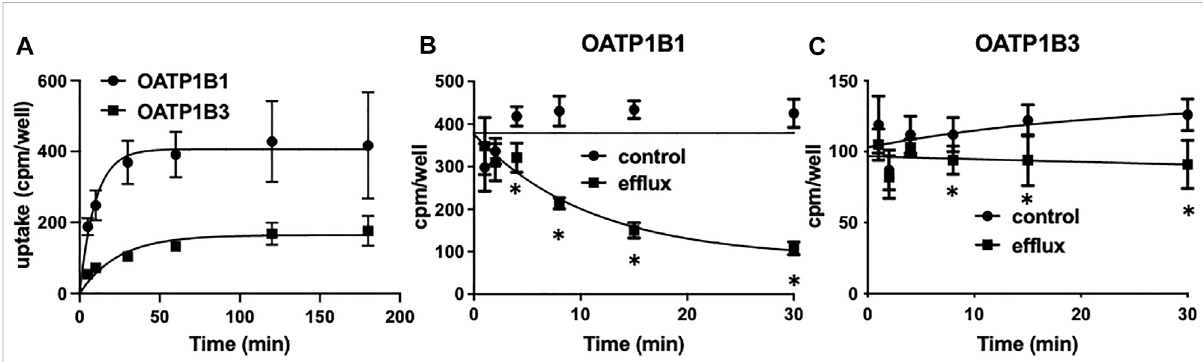
FIGURE 1 OATP1B1- and OATP1B3-mediated time-dependent uptake (A) and ef fl ux (B,C) of estradiol-17 β -glucuronide using stable CHO cell lines. (A) Uptake of 10 nM [ 3 H]-estradiol-17 β -glucuronide into CHO cells stably expressing OATP1B1 (circles) or OATP1B3 (squares) was determined at room temperature over 180 min on 96-well plates. Values are means ± SD of three independent experiments. (B,C) After preloading the cells for 2 h with 10 nM [ 3 H]- estradiol-17 β -glucuronide ef fl ux was initiated by the addition of 100 µM unlabeled estradiol-17 β -glucuronide. Values are means ± SD of two independent experiments combined with 7-8 technical replicates. * p < 0.05 as compared to the